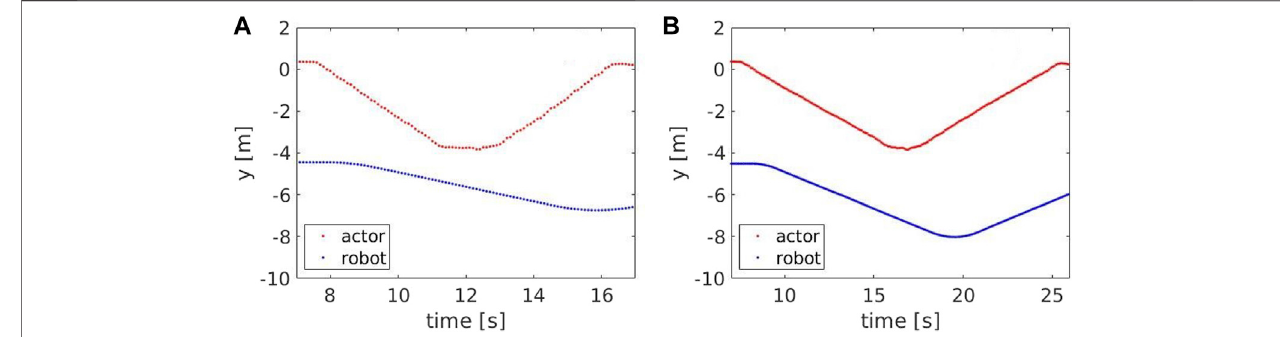
FIGURE 9 | The y component of the Actor ’ s hip center (red) and robot base (blue) for a speed of 1.3 m/ s (A) and 0.5 m/ s (B) .